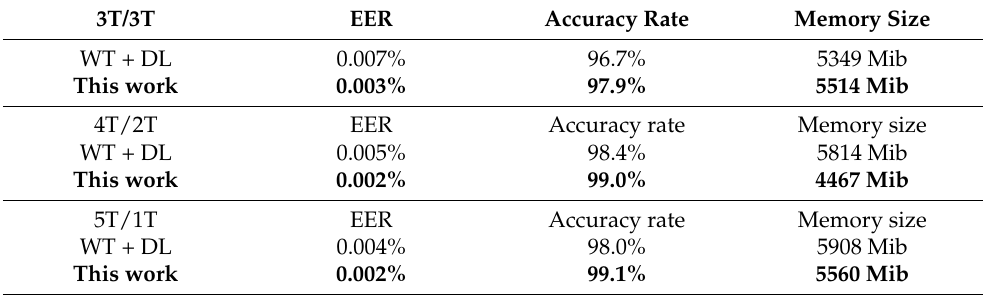
Table 1. Stability of identification for three vein image analysis scenarios using the FV-USM